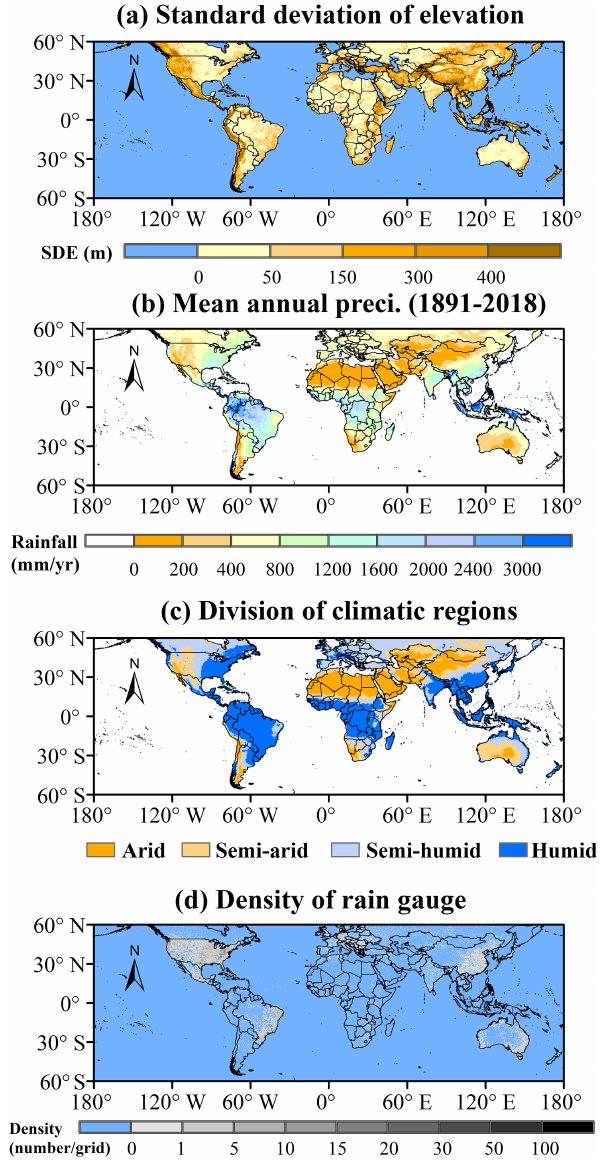
Figure 1. (a) Global map of topography; (b) global map of mean annual precipitation from 1891 to 2018 (128 years) based on the Global Precipitation Climatology Centre (GPCC) monthly gauge analysis; (c) division of the study region into four climate areas (i.e., humid, semi-humid, semi-arid, and arid); (d) the spatial den- sity of rain gauges used to obtain Climate Precipitation Center uni- fied (CPCU) data and China Gauge-based Daily Precipitation Anal- ysis (CGDPA)